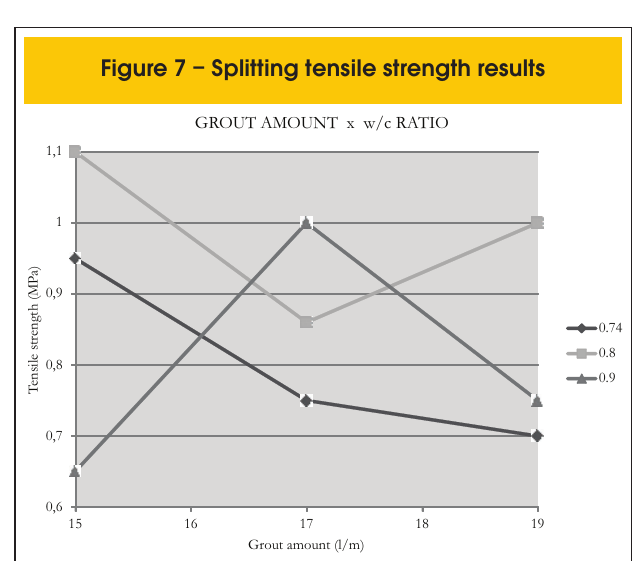
Figure 5 – Prismatic samples appearance after demolding